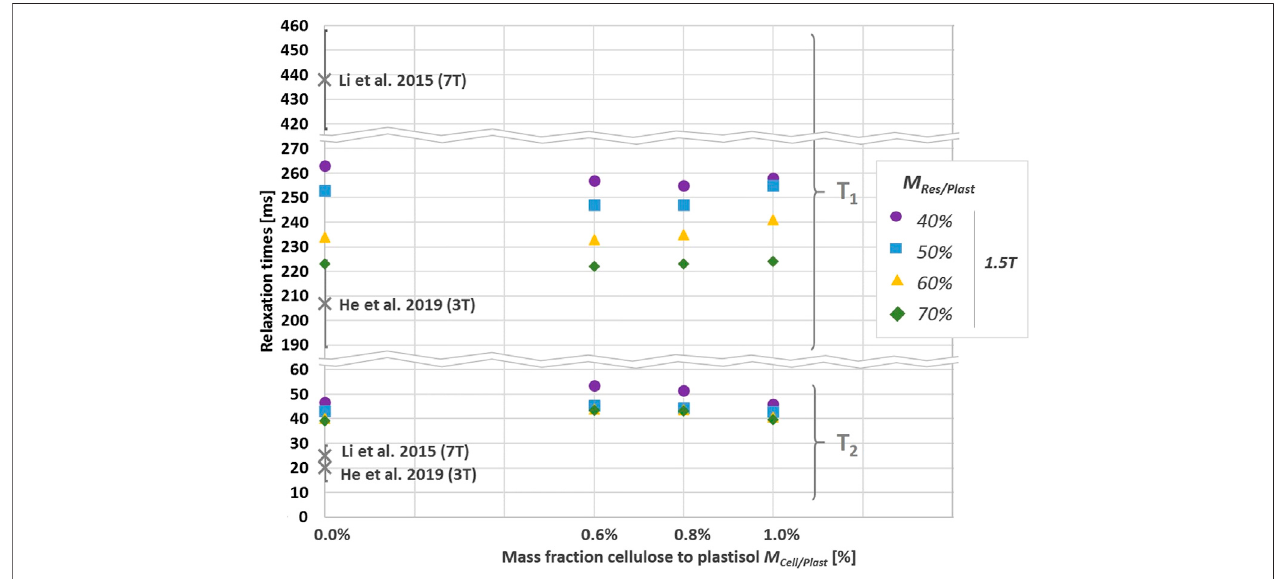
FIGURE2| LongitudinalT 1 and transverse T 2 NMR relaxation times acquired at1.5 Tforvaryingmassratiobetweencellulose and PVCP M Res/Plast andmassratio between resin and plasticizer M Res/Plast . These values are compared to T 1 and T 2 values from the literature measured in similar PVCP TMP (not containing cellulose) at 3 [38] and 7 T [36] (gray crosses).